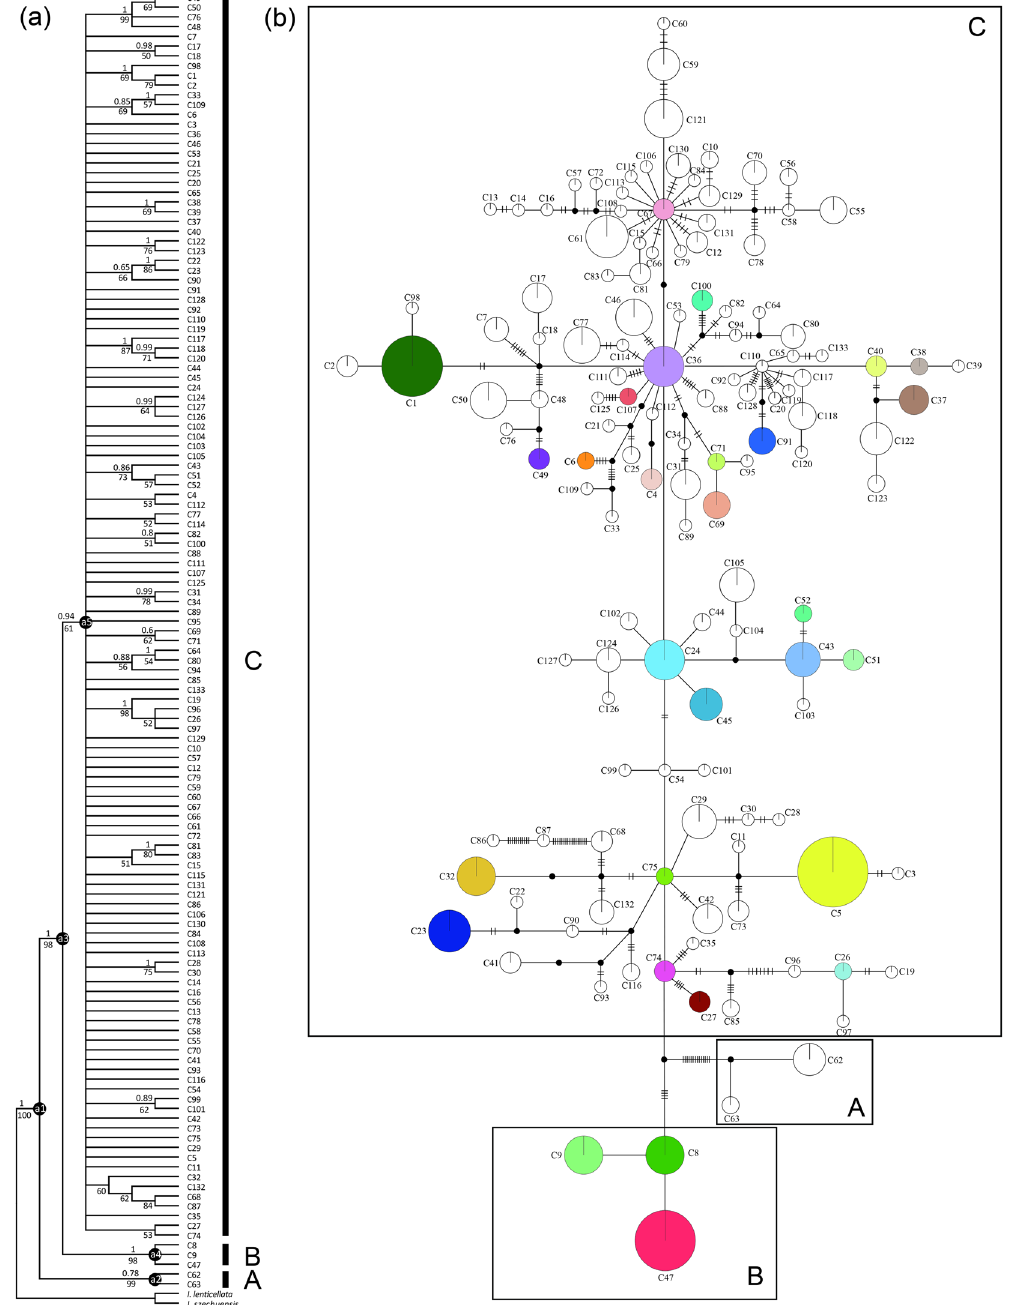
Figure 2. The evolutionary relationships among cpDNA haplotypes of Indigofera bungeana complex. ( a ) NJ phylogenetic tree of the 133 cpDNA haplotypes. Numbers above/below branches represent Bayesian posterior probabilities/NJ support values. ( b ) Maximun parsimony network. The size of circles corresponds to the frequency of each haplotype and black dots represent missing haplotypes (not sampled or extincted). Lineages (A, B, C) and clades (a1, a2, a3, a4, a5) correspond to the lineages and clades in Table 1 and Supplementary Table